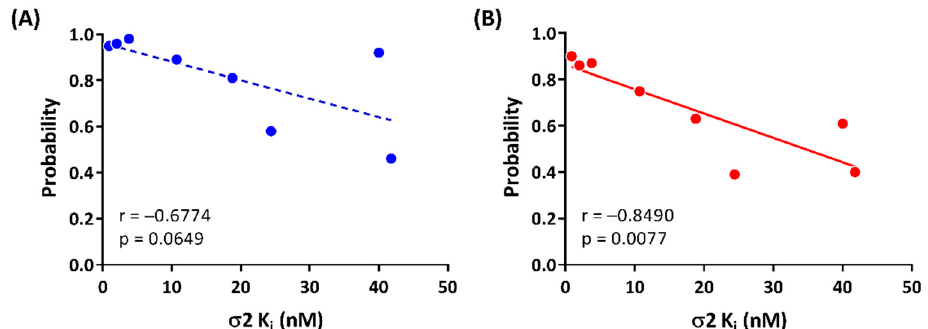
Figure 6. Correlations between σ 2R-binding affinities and ( A ) average of frequency of hydrogen bonds for ASP29 and TYR150 and ( B ) frequency of π interaction of TYR150.